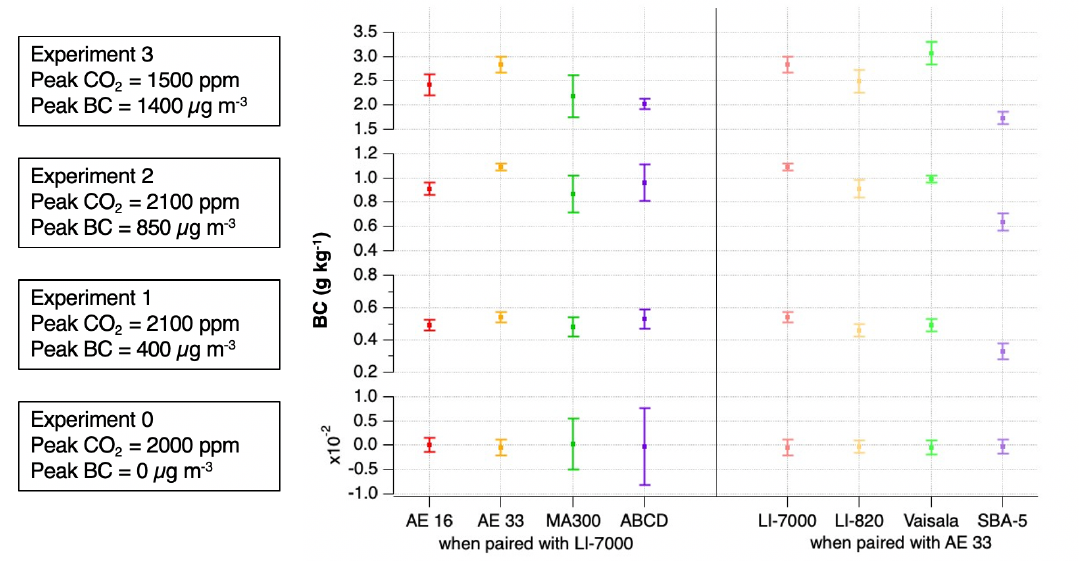
Figure A5. Average value ( ± 1 standard deviation) of emission factors determined from laboratory experiments that targeted BC emission factors of ~0, ~0.5, ~1, and ~2 g kg − 1 (Experiments 0–3, respectively and from bottom to top plots). The left panel shows the results of emission factors calculated with the specified BC sensors when paired with the LI-7000, and the right panel shows data from the specified CO 2 sensors when paired with the AE33.